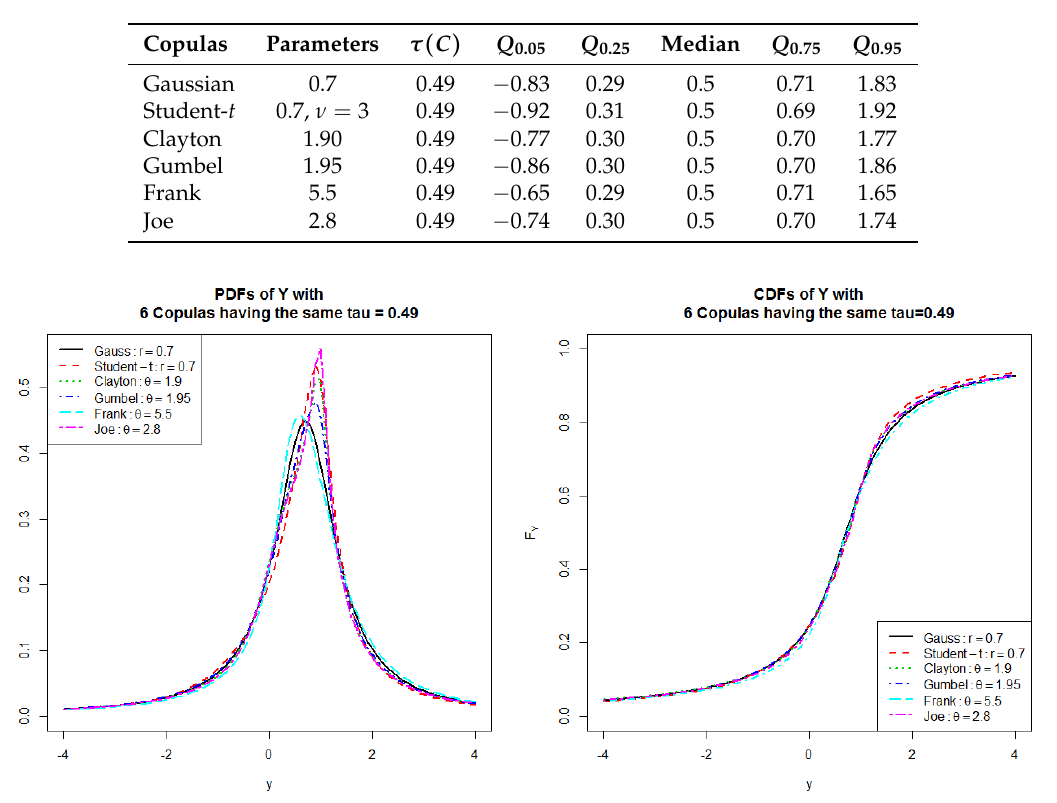
, where ( X 1 , X 2 ) modeled with six Copulas having the X 2